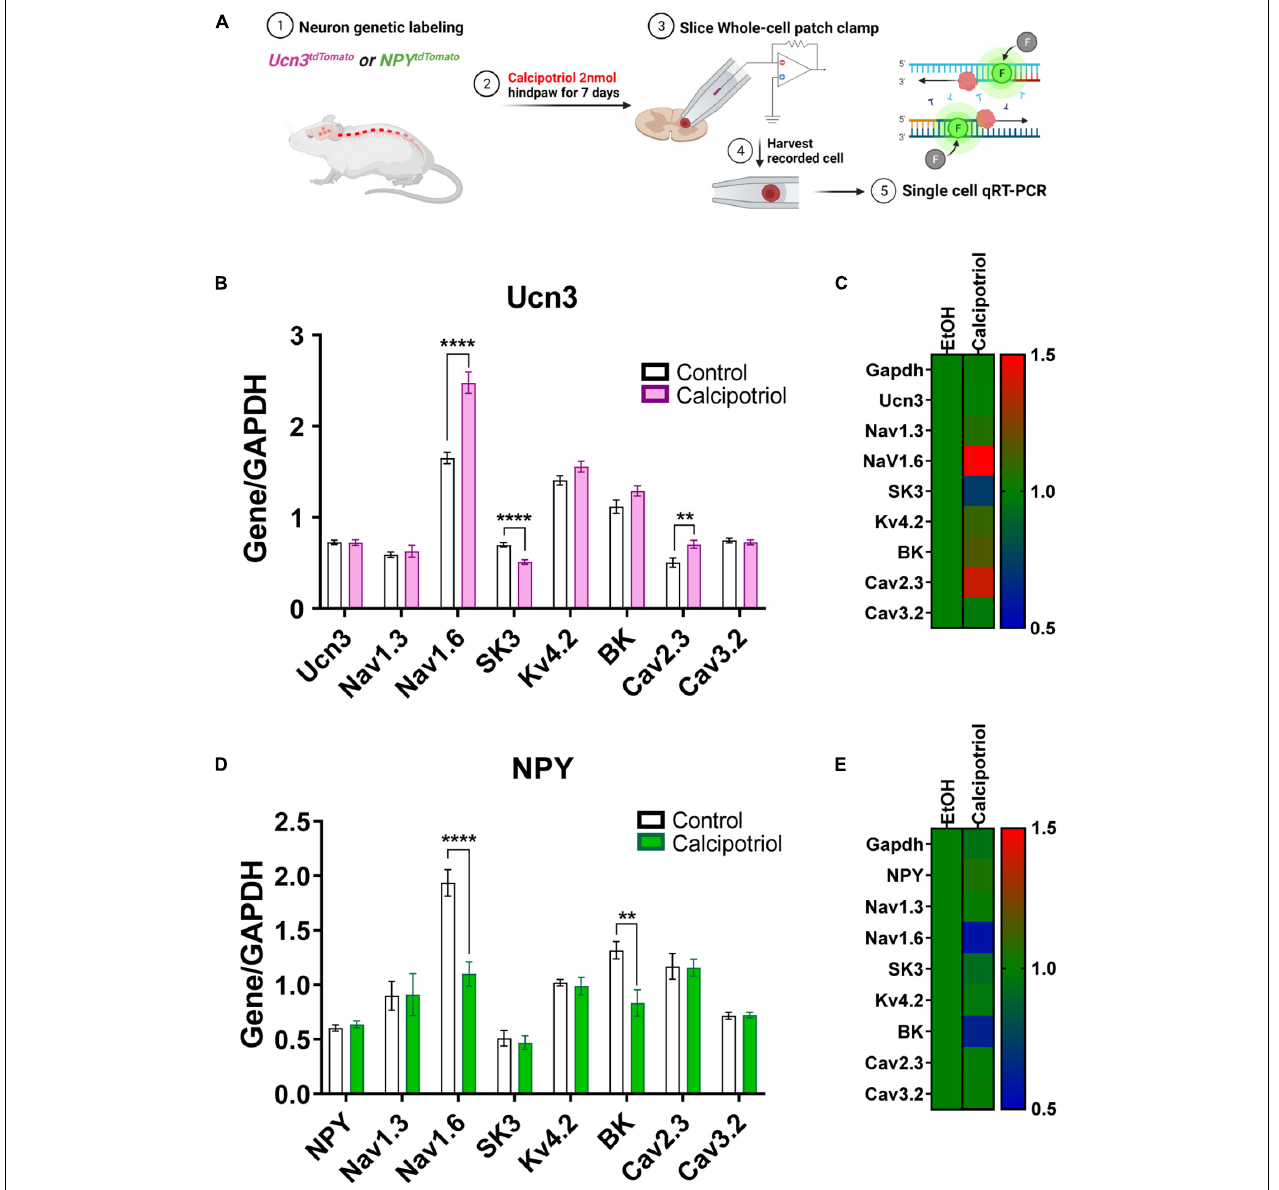
FIGURE 3 | Single-cell quantitative real-time PCR (qRT-PCR) analysis of recorded Ucn3 + and NPY + neurons. (A) Schematic diagram of the entire experimental method. (B) Single-cell qRT-PCR of normalized Ucn3 + neurons based on GAPDH in EtOH and calcipotriol-treated mice. Control, n = 14; chronic itch, n = 11. ** p < 0.01, **** p < 0.0001. Student’s unpaired t -test. (C) The control gene was normalized to 1, and the relative change for each gene is expressed as a heat map. Control, n = 14; chronic itch, n = 11. (D) Single-cell qRT-PCR of normalized NPY + neurons based on GAPDH in EtOH and calcipotriol-treated mice. Control, n = 23; chronic itch, n = 23. ** p < 0.01, **** p < 0.0001. Student’s unpaired t -test. (E) The control gene was normalized to 1, and the relative change for each gene is expressed as a heat map. Control, n = 23; chronic itch, n =